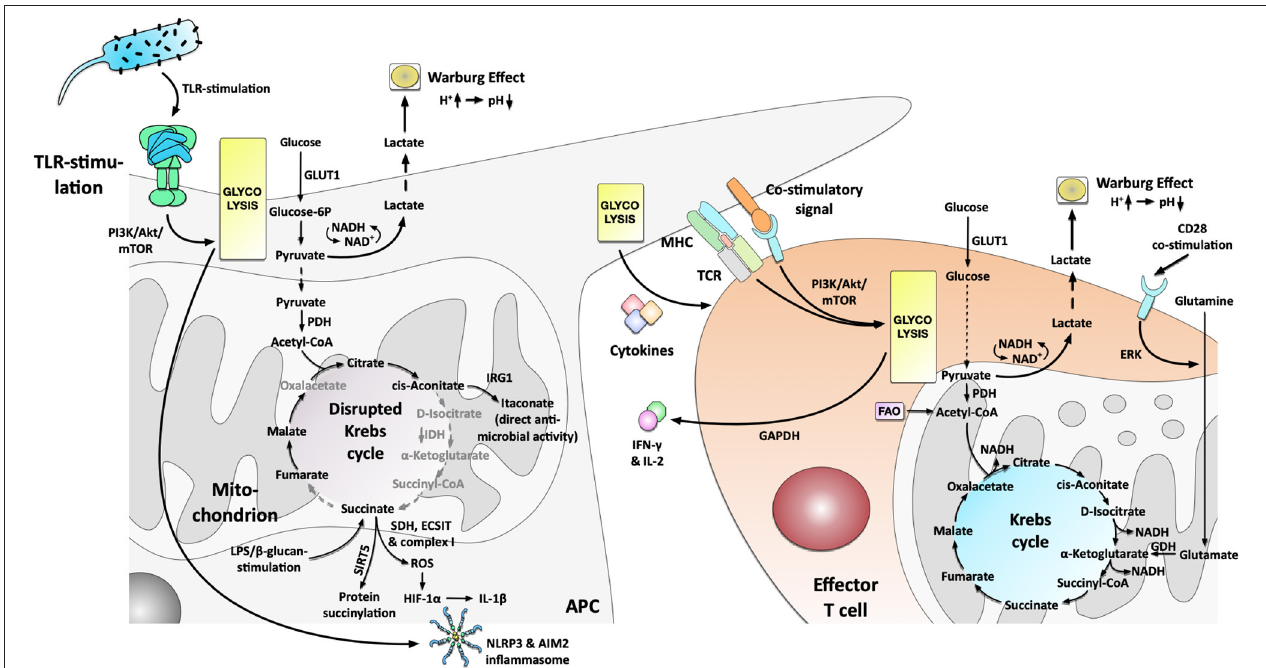
FIGURE 2 | Metabolic phenotype and the connection to immune cell effector function in activated Antigen Presenting Cells and effector T cells. Antigen Presenting Cells (APCs) activated by e.g., TLR-stimulation switch to a predominant production of energy via glycolysis that drives cytokine production and results in the production and excretion of lactate (Warburg Effect). The switch toward glycolysis is driven by the PI3K/Akt/mTOR-axis. The disrupted Krebs cycle resulting from an undersupply of pyruvate in the mitochondrion is used to (I) generate important immune effector molecules (e.g., itaconate, ROS), (II) fuel post-translational protein modification (e.g., succinylation or acetylation), and (III) free up the mitochondria from energy production in order to promote inflammatory responses via an SDH-, ECSIT- and complex I-dependent production of ROS which in turn drive HIF-1 α - and inflammasome-dependent IL-1 β production. Activated T cells PI3K/Akt/mTOR-dependently increase their glycolysis but also retain metabolic flexibility with the ability to fuel the mitochondrion with glutamine. Increased glutamine uptake and metabolism is regulated by CD28-dependent ERK-signaling. Moreover, the glycolytic enzyme GAPDH regulated IFN- γ secretion by interacting with IFN- γ mRNA. For more information see text. TLR, “Toll”-like receptor; GLUT1, glucose transporter 1; PDH, pyruvate dehydrogenase; IRG-1, immune-responsive gene 1; IDH, isocitrate dehydrogenase; SDH, succinate dehydrogenase; ROS, reactive oxygen species; HIF-1 α , hypoxia inducible factor 1 alpha; SIRT5, Sirtuin 5; ECSIT, evolutionarily conserved signaling intermediate in Toll pathways; MHC, major histocompatibility complex; TCR, T cell receptor; PI3K, phosphoinositide 3-kinase; Akt, protein kinase B; mTOR, mammalian target of rapamycin; GAPDH, glyceraldehyde 3-phosphate dehydrogenase; GDH, glutamate dehydrogenase; ERK, extracellular regulated kinase; FAO, fatty acid